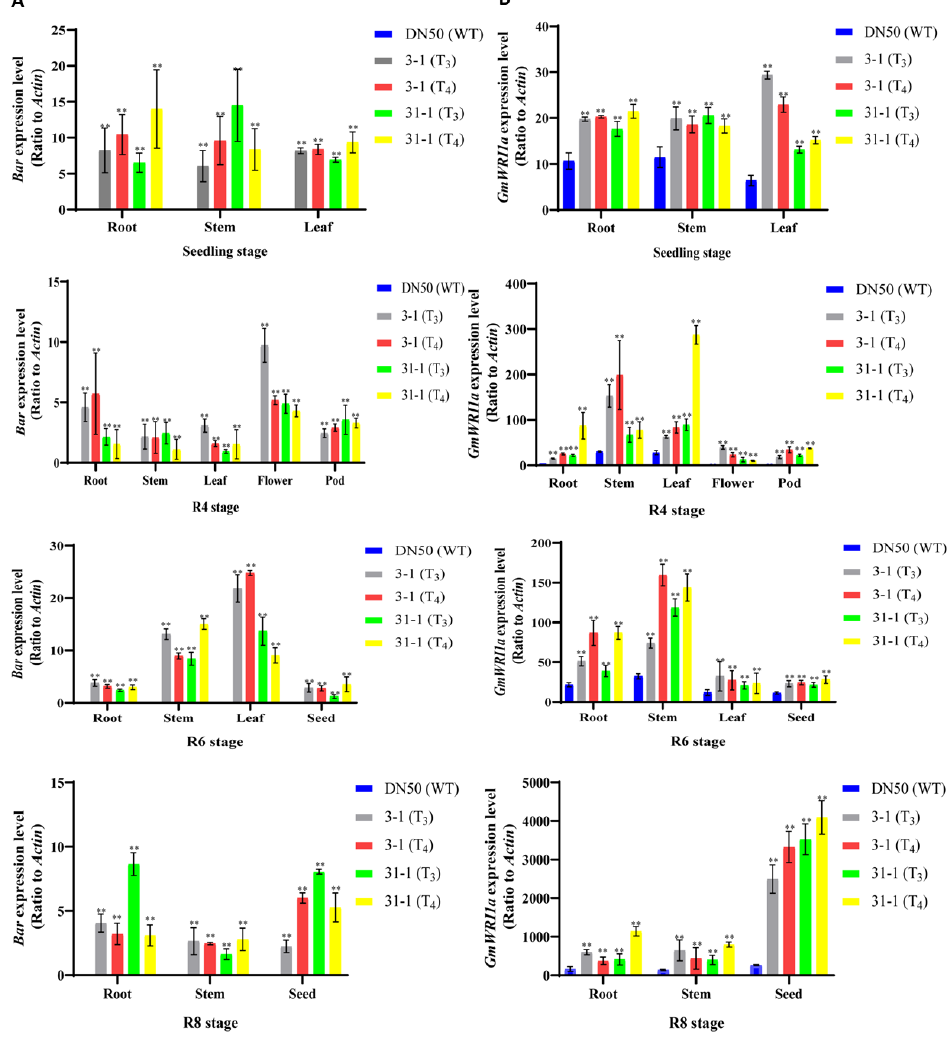
Figure 4. Relative expression level of GmWRI1a and bar genes in the different organs during development stages. Transgene expression was normalized using GmActin4 gene and calibrated using the same sample under control conditions. Data shown represent the means ± SD of three independent experiments, with each experiment consisting of three technical replicates. Statistically significant differences between transgenic and WT plants are marked with asterisks (** p < 0.01; ANOVA). ( A ) The relative expression level of the bar gene in the different organs at four development stages from the T 3 and T 4 generation 3-1 and 31-1 soybean. ( B ) The relative expression level of the GmWRI1a gene in the different organs at four development stages from the T 3 and T 4 generation 3-1 and 31-1